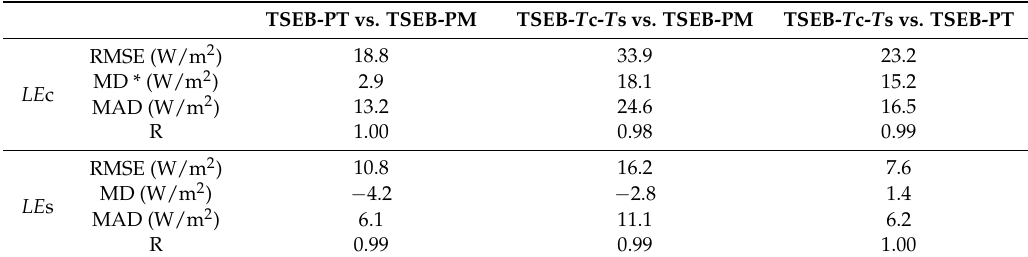
Figure 7. The intercomparison of LE C (first row) and LE S (second row) derived from TSEB-PT, TSEB-PM, and TSEB- T C - T S in the kernel experimental area on 10 July 2012. The intercompared LE C pairs are ( a ) TSEB-PM vs. TSEB-PT; ( b ) TSEB-PM vs. TSEB- T C - T S ; ( c ) TSEB-PT vs. TSEB- T C - T S . The intercompared LEs pairs are ( d ) TSEB-PM vs. TSEB-PT; ( e )TSEB-PM vs. TSEB- T C - T S ; ( f ) TSEB-PT vs. TSEB- T C - T S . Table 2. Statistics summarizing the intercomparison of LE C and LE S derived from TSEB-PT, TSEB-PM, and TSEB- T C - T S in the kernel experimental area.